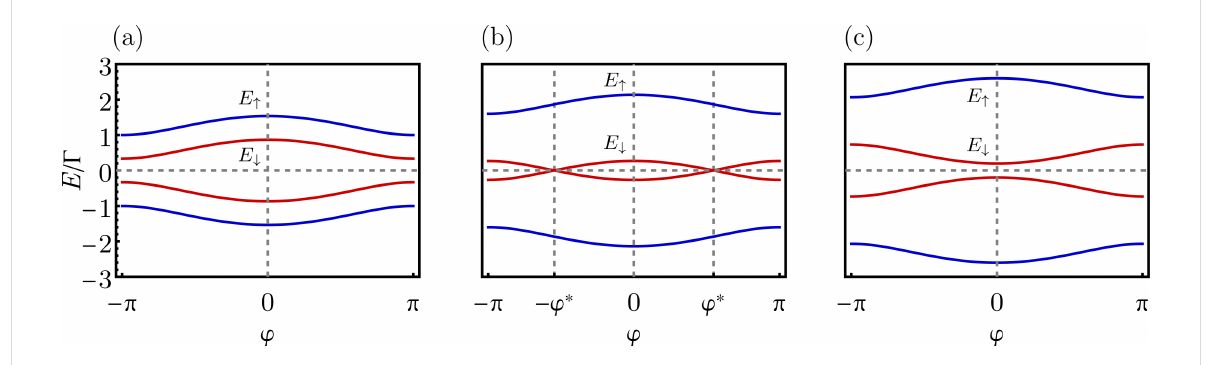
Figure 2: Energy spectrum of a two-level quantum dot coupled with two superconducting leads (SC–QD–SC junction), consisting of a set of four Andreev levels, i.e., two single-particle levels ± E ↑ (blue curves) and ± E ↓ (red curves), as a function of the gauge-invariant phase difference φ be- tween the two superconducting leads. We take ε = 2 Γ /3 and U = 0. The three panels correspond to different values of the Zeeman field: (a) small fields | B | < B min , (b) intermediate fields B min < | B| < B max , with the particle–hole gap closing at the gapless points ± φ * (see Equation 21), and (c) large fields | B | > B max